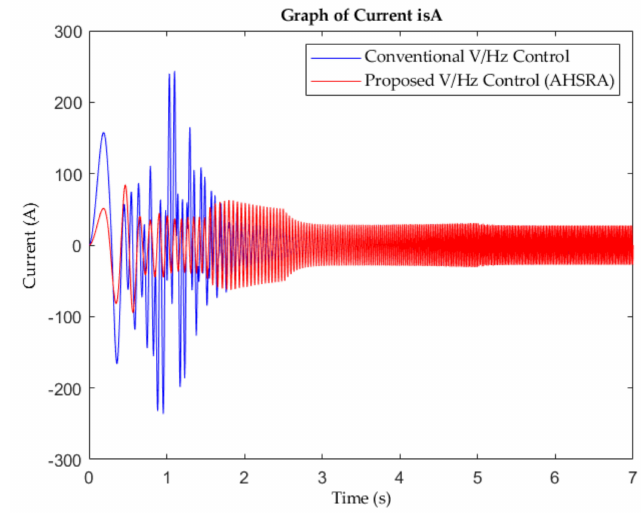
Figure 10. Stator phase A current i sA —ASHRA (red) vs. conventional V/Hz (blue).